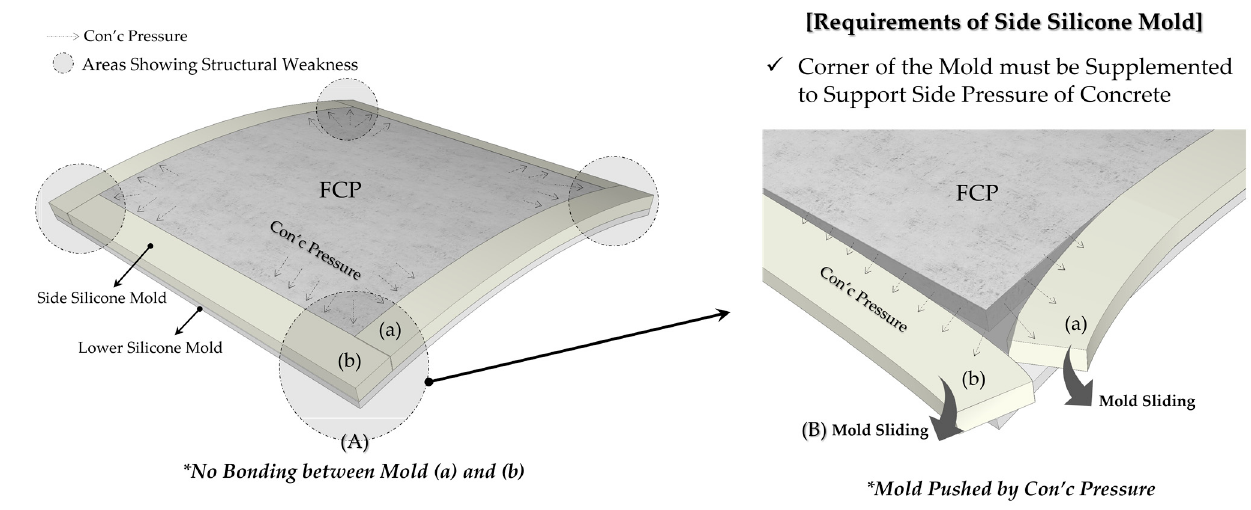
Figure 1. Limitation of Side Silicone Mold used in Previous Study.